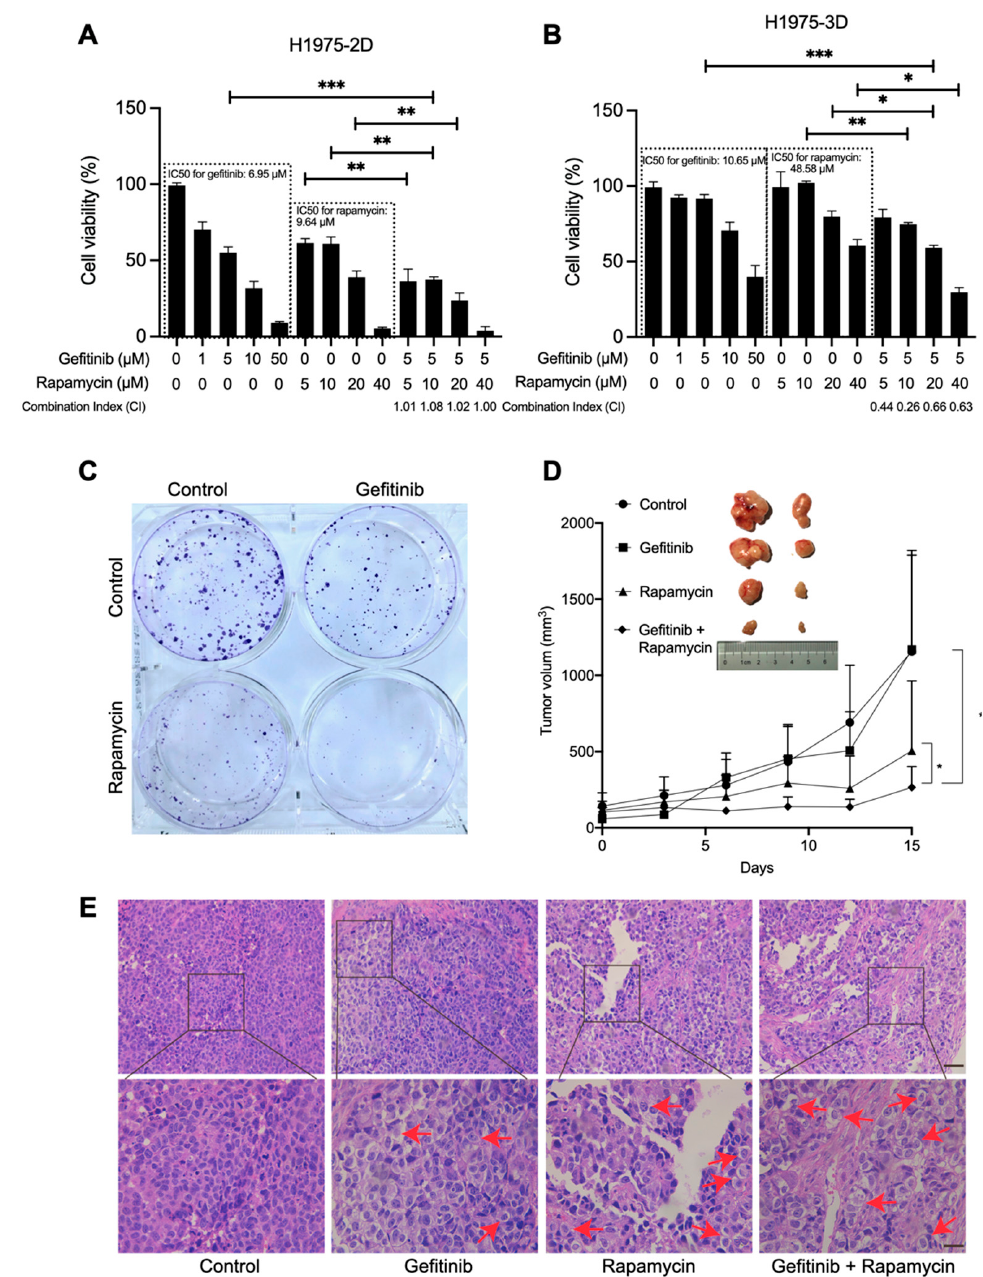
Figure 1. Combination therapy of rapamycin and gefitinib attenuates H1975 cell growth. ( A ) CCK-8 assay of 2D-cultured H1975 cells under the treatment with gefitinib, rapamycin, and their combination for 48 h at a gradient concentration, as indicated. ** p < 0.01 and *** p < 0.001. ( B ) Cell viability assay of 3D cultures under the treatment with gefitinib, rapamycin, and their combination for 48 h at a gradient concentration, as indicated. ** p <0.01 and * p < 0.05. ( C ) Clonogenic assay performed in 2D-cultured H1975 cells treated with gefitinib (5 μ M) and/or rapamycin (10 μ M). ( D ) Photograph of harvested H1975 tumor xenografts after 15 days of treatment and tumor xenograft growth within 15 days of treatment. (Control: phosphate-buffered saline (PBS); gefitinib: 150 mg/kg; rapamycin: 2 mg/kg.) * p < 0.05. ( E ) Light microscopic analysis of H&E-stained H1975 tumor xenograft sections after 15 days of treatment with different therapies. Red arrows indicate cell necrosis.